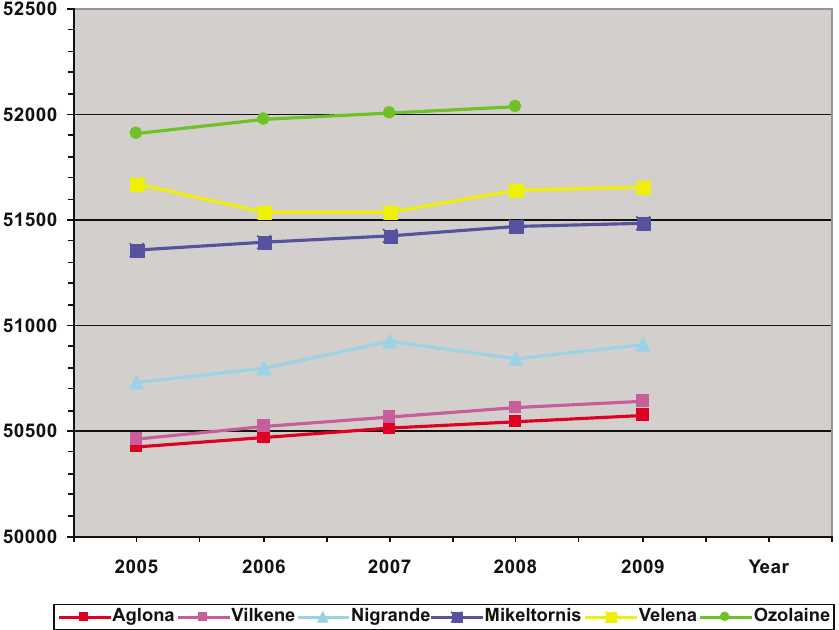
Fig. 2. The variation of total field F mean annual values in nT (during 2005–2009)